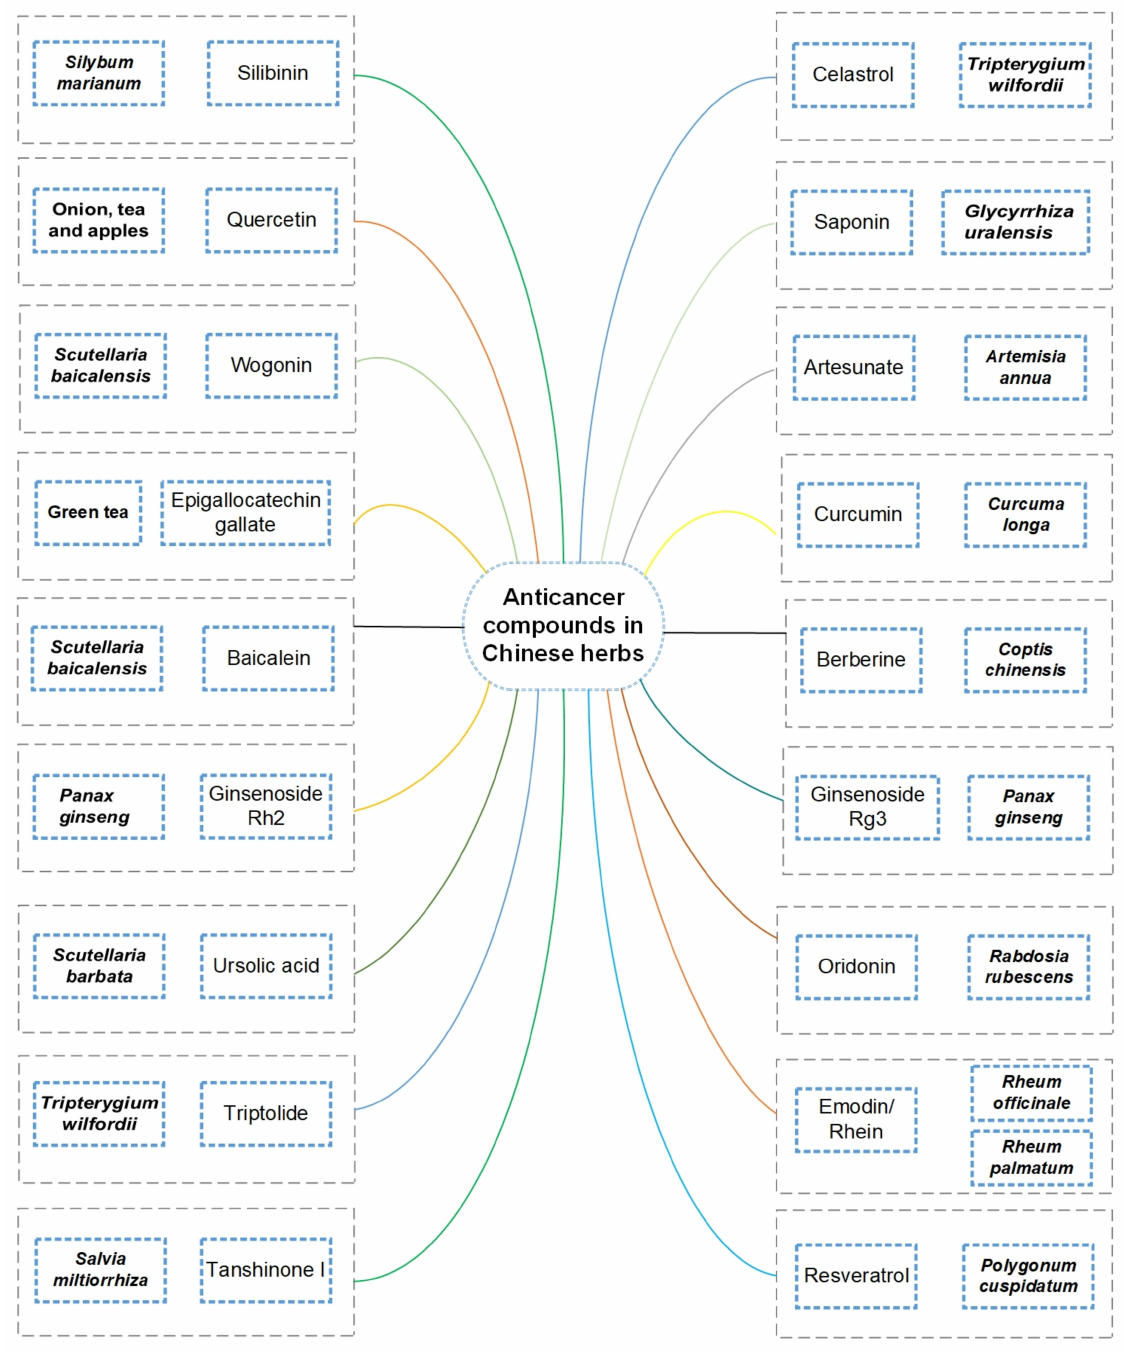
Figure 5. Major anticancer bioactive compounds isolated from Chinese herbs are presented. The in vitro anticancer activity of the Chinese herb Cornus officinalis (Shanzhuyu) was evaluated, along with the cytotoxic effect of Shanzhuyu-prepared AgNPs against human gastric carcinoma, prostate cancer, and liver cancer cell lines [92]. Another study reported the use of Cibotium barometz root extract for the synthesis of AgNPs, which acts as reducing and stabilizing agents with antimicrobial potential and cytotoxicity, in murine macrophages [167]. Four monographs on Chinese anticancer medicine have been pub- lished, and they have recorded more than 400 anticancer agents associated with Chinese herbal medicine [46]. However, the anticancer targets of these medicinal compounds are unknown, which is the major challenge in the development of Chinese herbal